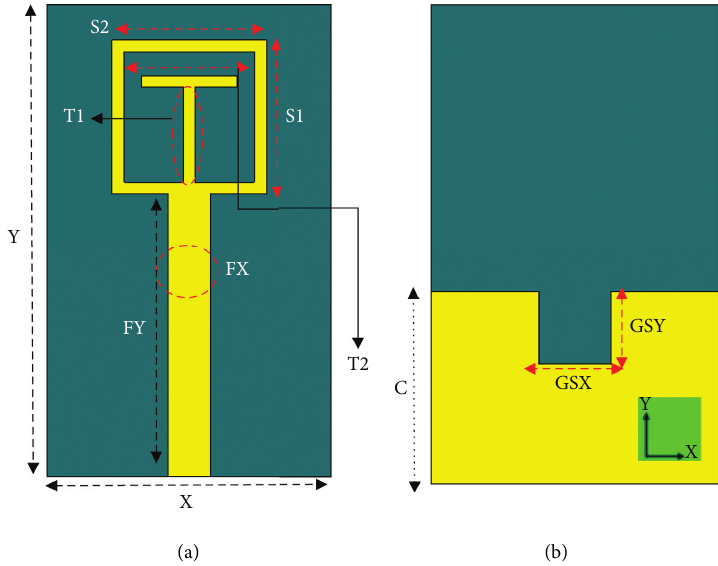
Figure 1: Proposed antenna design: (a) front and (b) back.